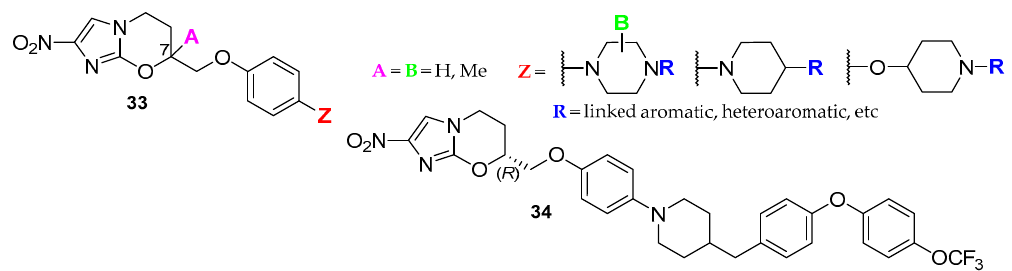
Figure 10. Genus of compounds ( 33 ) with transposed side chains and most potent analogue ( 34 ).